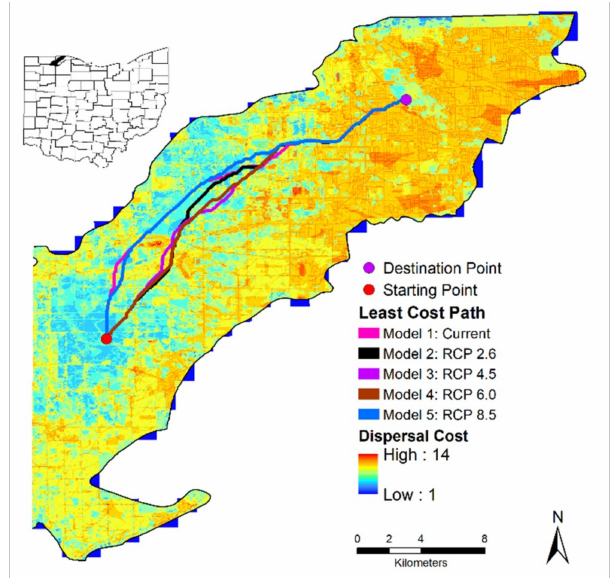
Figure 4. The least cost paths that individuals can take from Oak Openings Preserve to Wildwood Metroparks for five scenarios. Model 1: Current, Model 2: 2050 Representative Concentration Pathway (RCP) 2.6, Model 3: 2050 RCP 4.5, Model 4: 2050 RCP 6.0, and Model 5: 2050 RCP 8.5. Least cost paths (colored lines) are overlaid on the cost layer with high travel cost (in red) and low travel cost (in blue) for current